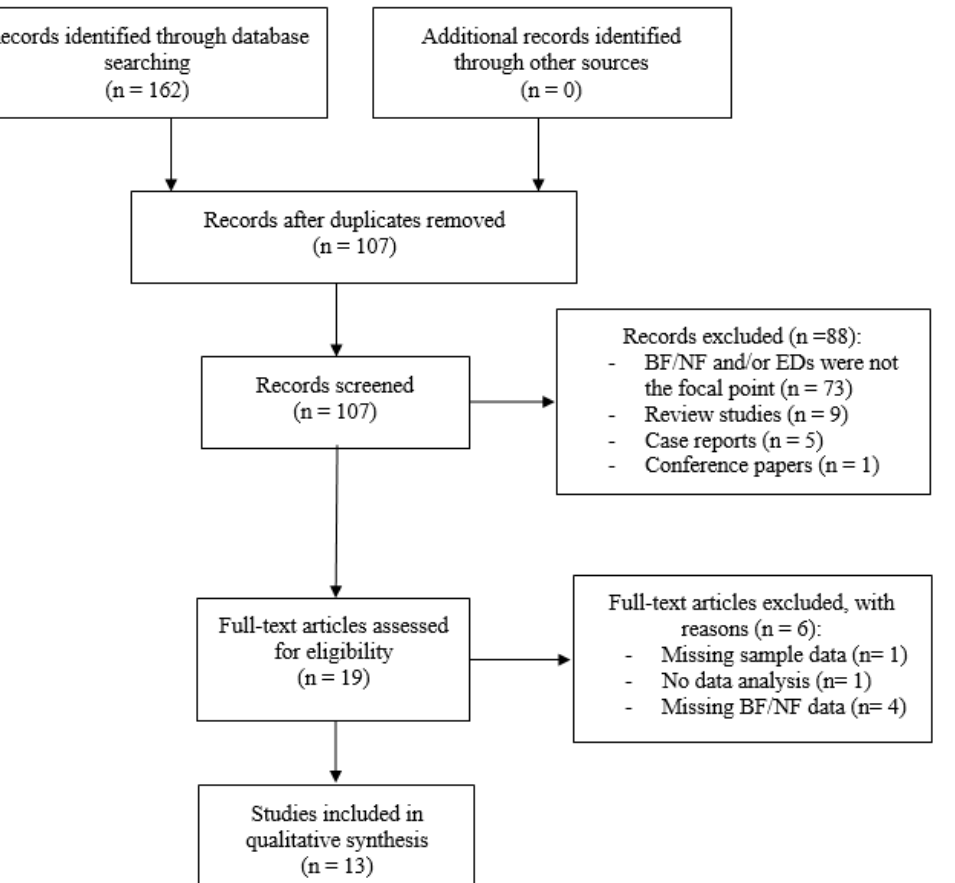
Figure 1. Flow diagram of selection of studies. Abbreviation: BF = Biofeedback; NF = Neurofeedback; EDs = Eating Disorders.